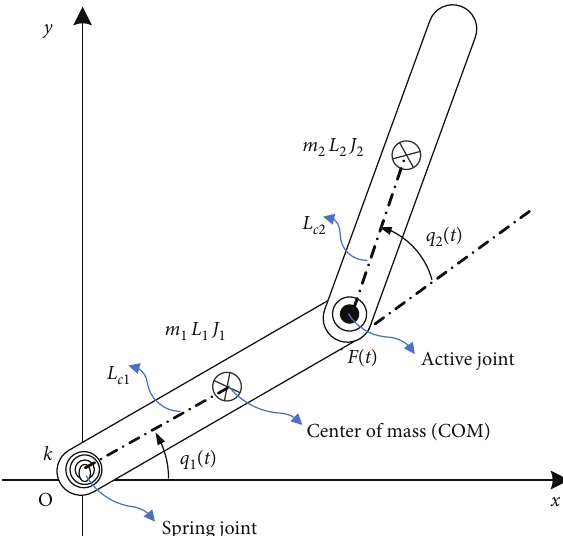
Figure 1: Model of underactuated horizontal spring-coupled two- link manipulators